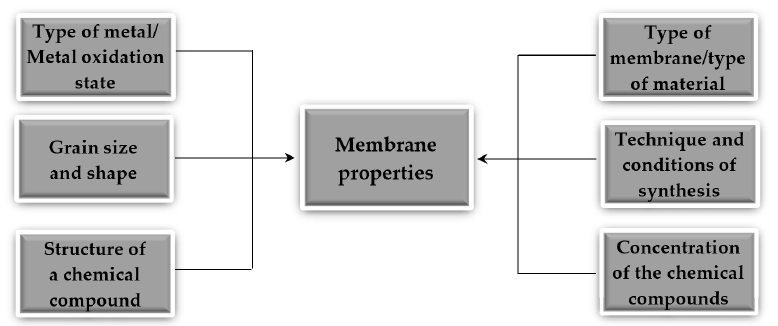
Figure 2. The main factors influencing the nature of the material of the membrane and its proper-